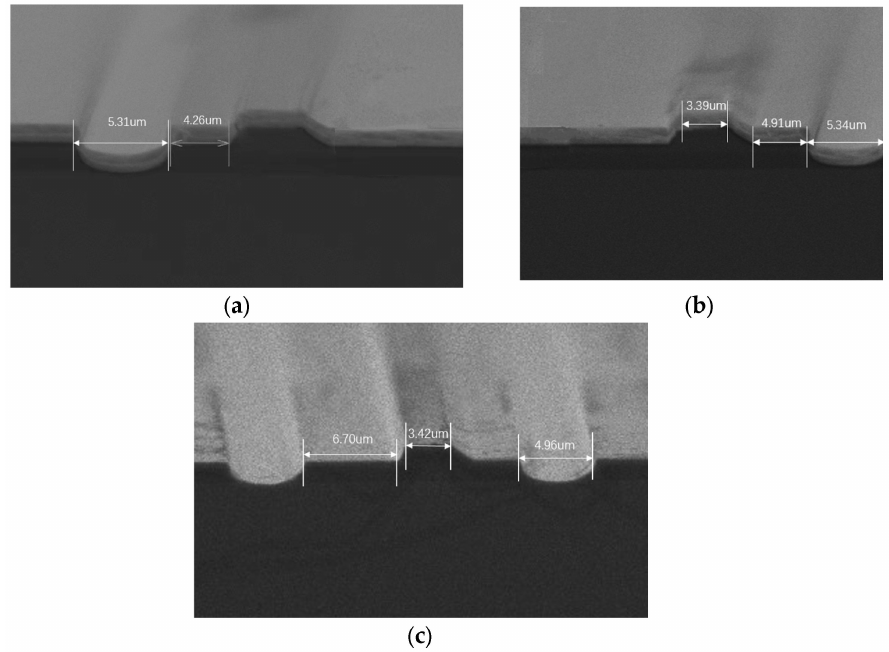
Figure 6. Diagram of the current diffusion direction.